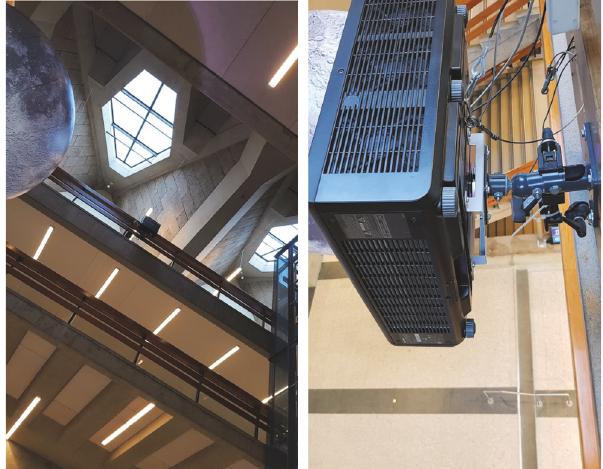
Figure 3: IMOVE setup and installation